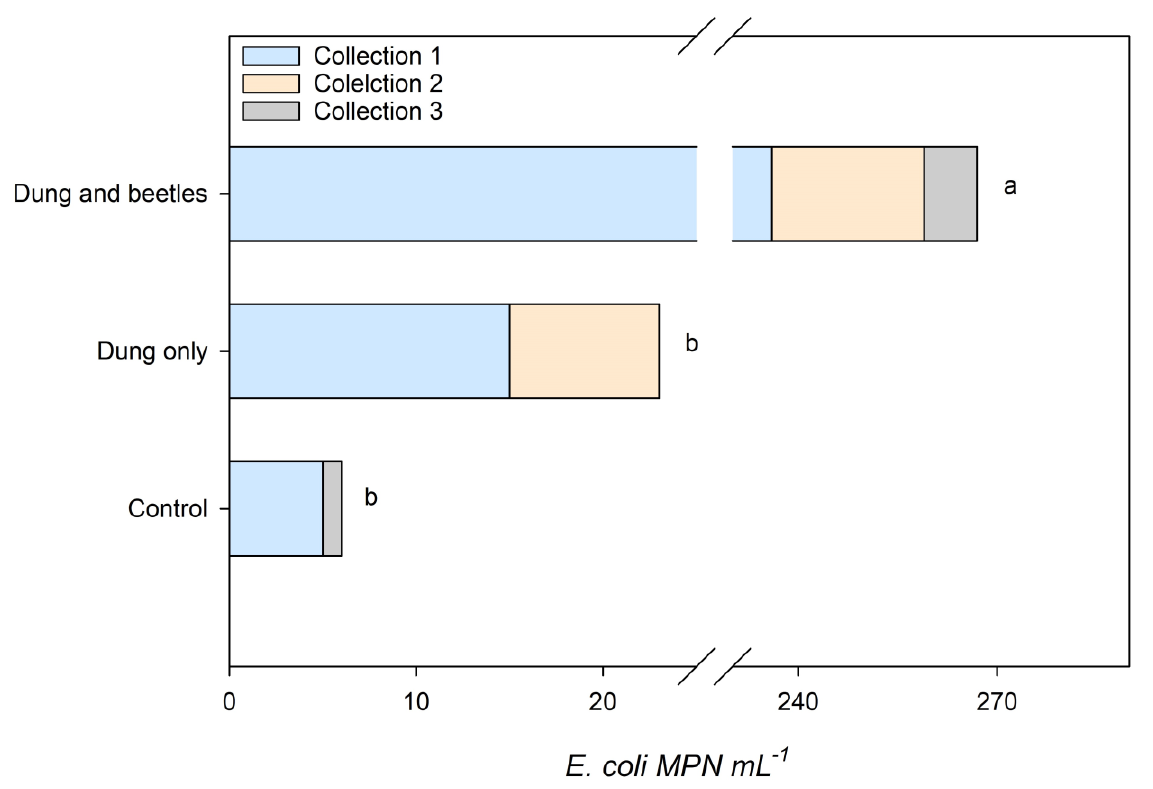
Figure 3. Cumulative leaching of E. coli bacteria from lysimeter columns measured at each leachate collection. Error bars represent standard error. Different letters represent significant differences between means of treatments. Bars sharing the same letters are not significantly different within each treatment at α = 0.05.